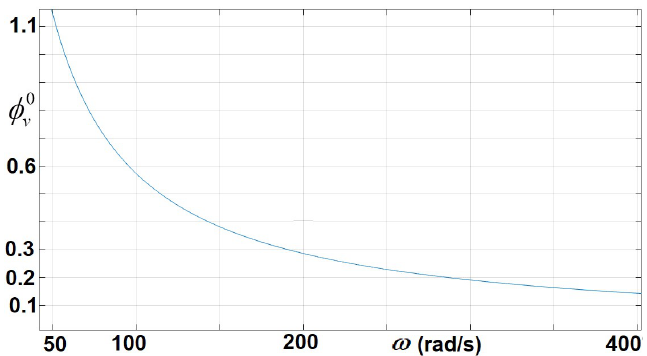
Figure 9. Software-OCC. Angle φ v ( 0.10/div) vs. angular frequency (rad/s) as a function of dc current = V 0 p = 467 V, T SW = 8.33 ms, C = 1000 µ F, L = 1 mH and K p 1 = K I 1 = K I = I 0 , V ∗ 0